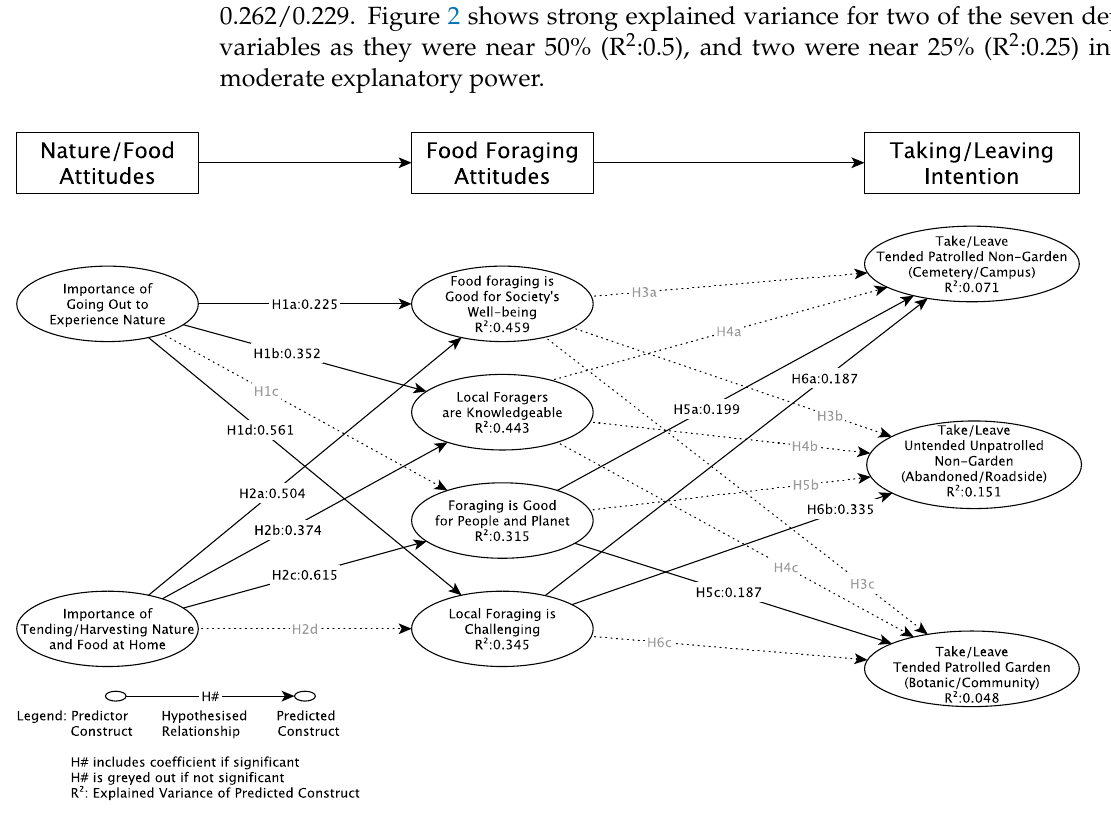
Figure 2 . Conceptual Model Results . Figure 2. Conceptual Model